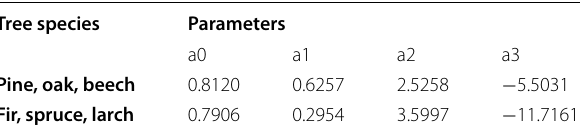
Table 8 Parameters for the taper function according to Eq. (7) (Fonweban et al., 2011) Tree